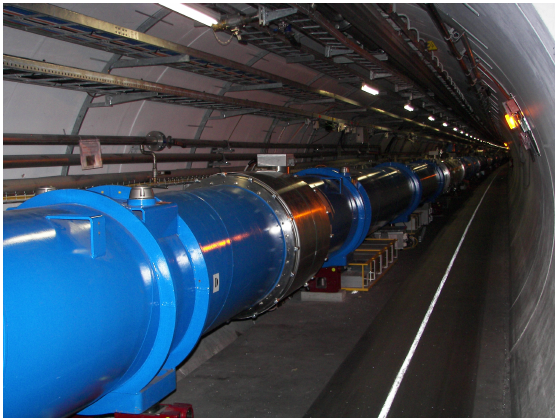
Figure 1. The LHC tunnel. The blue cryostat contains superconducting main dipole magnets. The protection unit is visible on the floor under the magnet (yellow rack). The photo taken by A.S. in 2007.